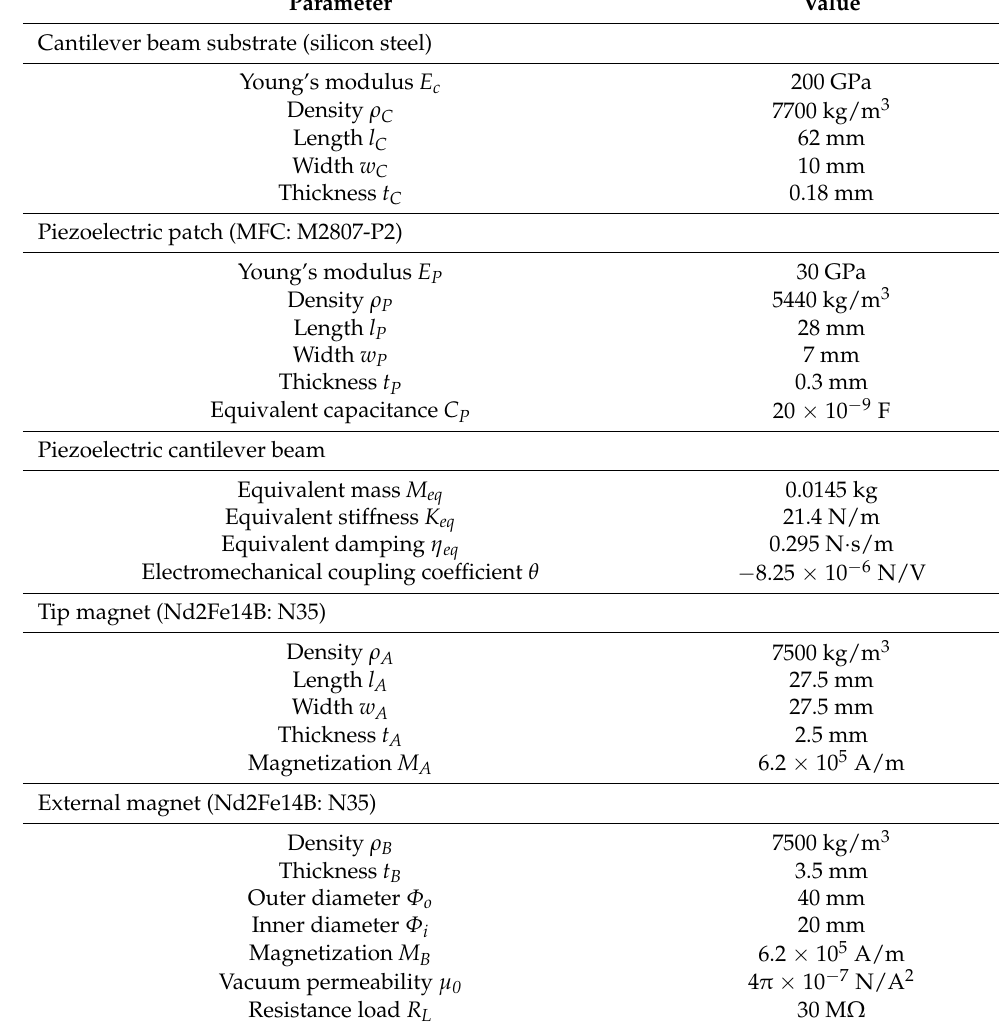
Table 1. Structural parameters of the